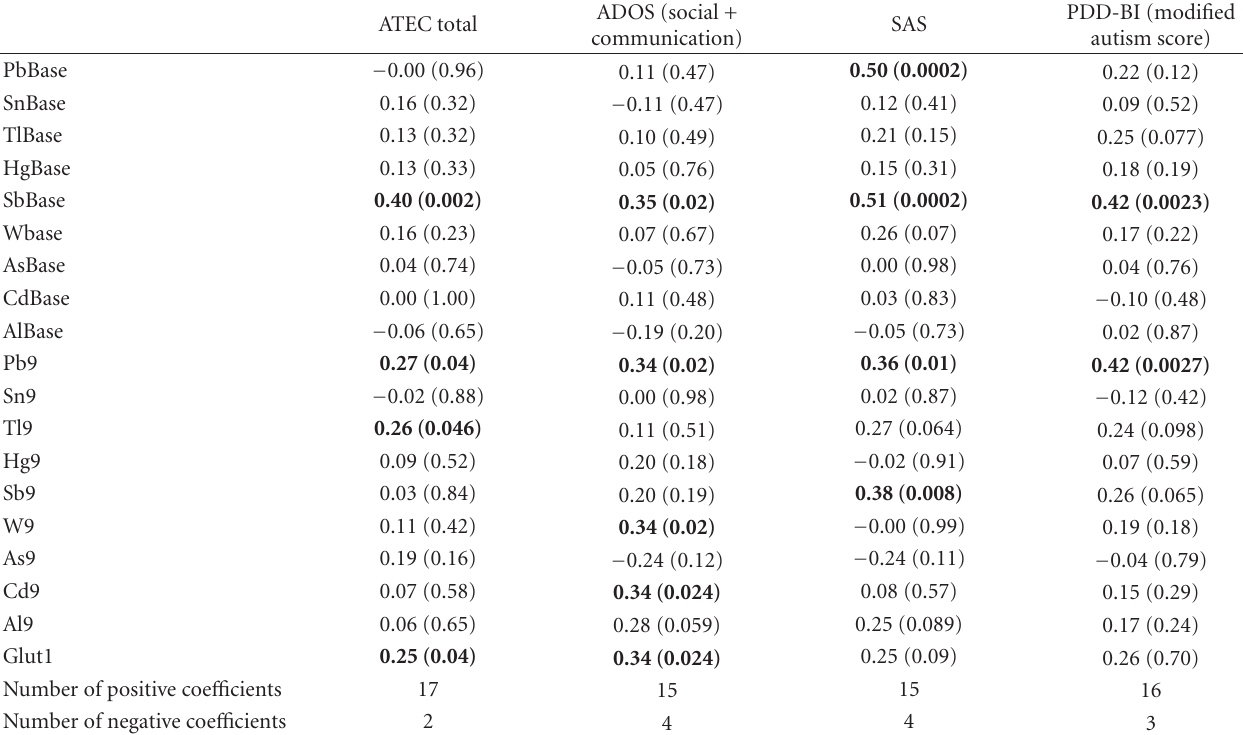
Table 4: Correlation analyses of initial autism severity versus urinary metal excretion and initial glutathione. The metal excretion is measured both at Baseline (before DMSA) and after the 9th dose of DMSA. The first number in each cell is the correlation coe ffi cient ( r ) and the second number is the P -value. Correlation coe ffi cients with P < .05 are in bold. The last 2 rows list the total number of positive and negative correlation coe ffi cients,